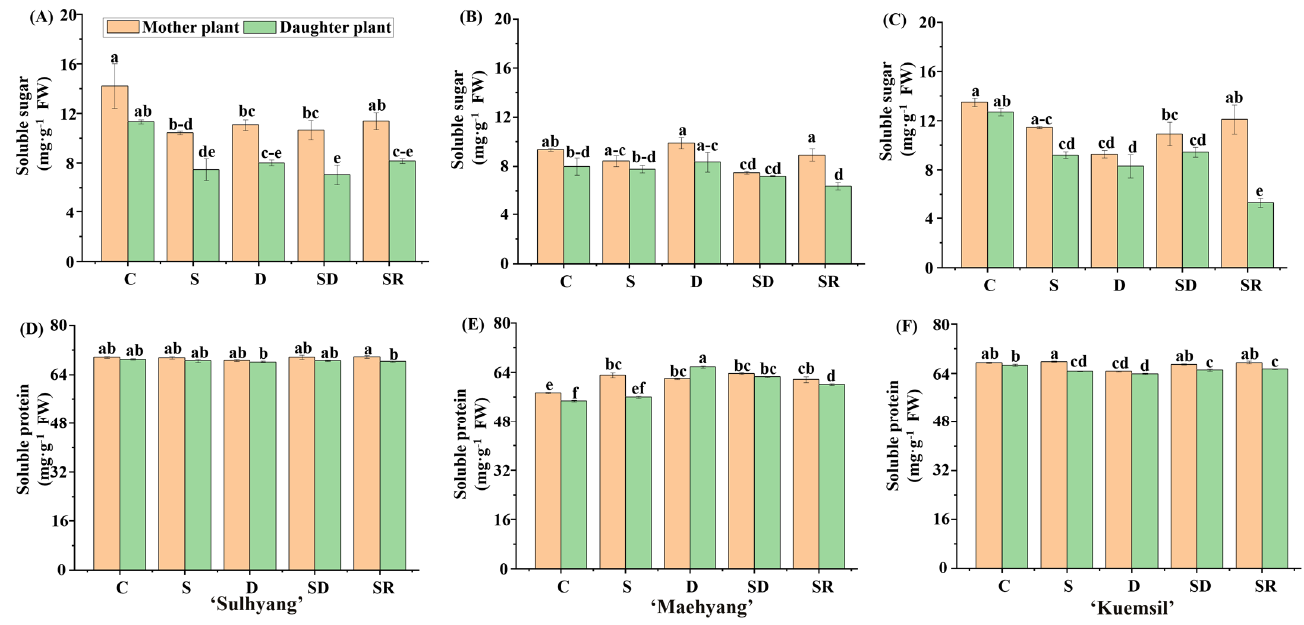
Figure 7. The contents of soluble sugars and proteins of strawberry ‘Sulhyang’ ( A , D ), ‘Maehyang’ ( B , E ), and ‘Kuemsil’ ( C , F ) as affected by the Si treatments. Lowercase letters indicate significant differences calculated by the Duncan’s multiple range test at p ≤ 0.05: C, control; S, sprayed “mother” plant; D, drenched “mother” plant; SD, dressed “mother” plant; and SR, sprayed “daughter” plant.